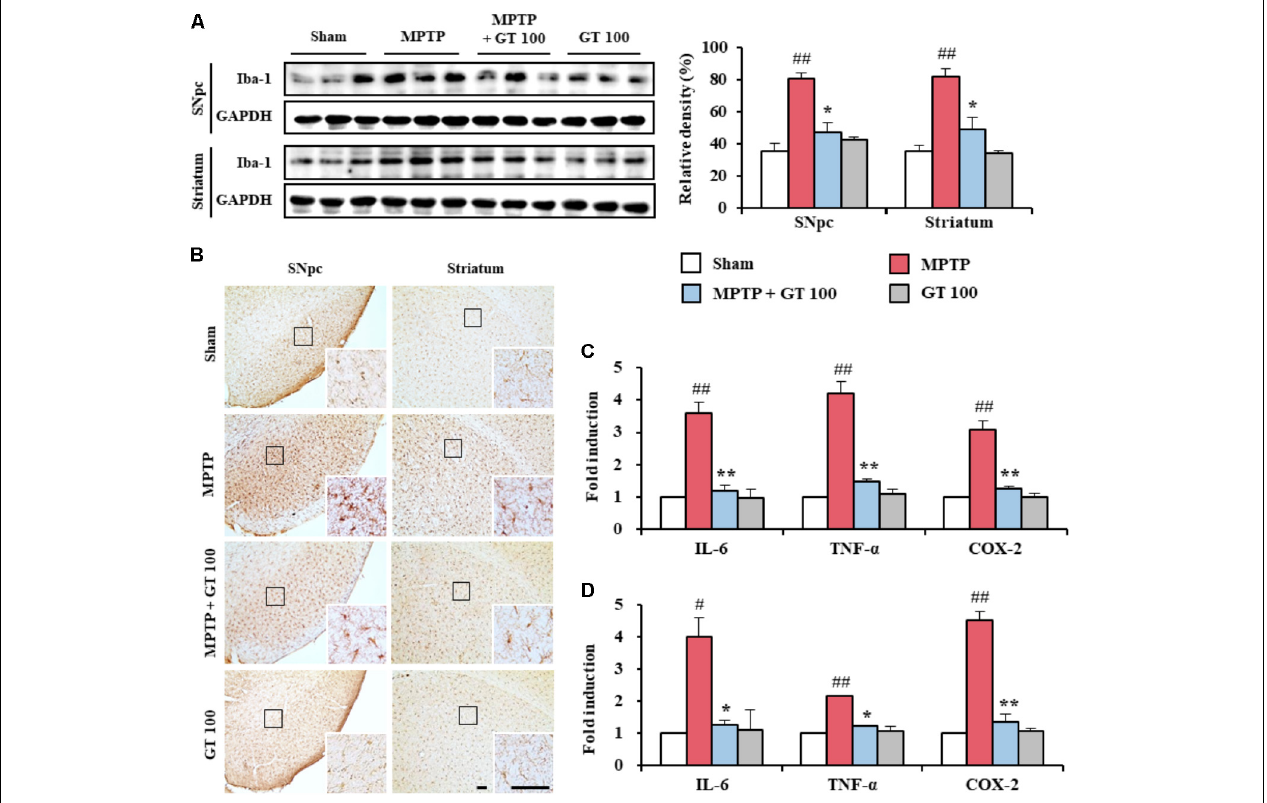
FIGURE 2 | Gintonin attenuates activation of microglia and inflammatory mediators in the SNpc and striatum after MPTP injection. (A) SNpc and striatum from each group ( n = 3 per group) 7 days after MPTP-injection were quantified by immunoblot analysis using Iba-1 antiserum. The left panels illustrate representative Western blots. (B) SNpc and striatum sections ( n = 3 per brain) 7 days after MPTP injection were immunostained with Iba-1 antiserum. Insets display high magnification micrographs of the areas marked with squares. (C,D) Real-time PCR was used to quantify mRNA expression of IL-6, TNF- α , and COX-2 in SNpc and striatum ( n = 3 per group) from day 7 after MPTP injection (SNpc, C ; striatum, D ). Scale bar = 50 µ m. ANOVA test; # p < 0.05 and ## p < 0.01 vs. Sham group; ∗ p < 0.05 and ∗∗ p < 0.01 vs. MPTP